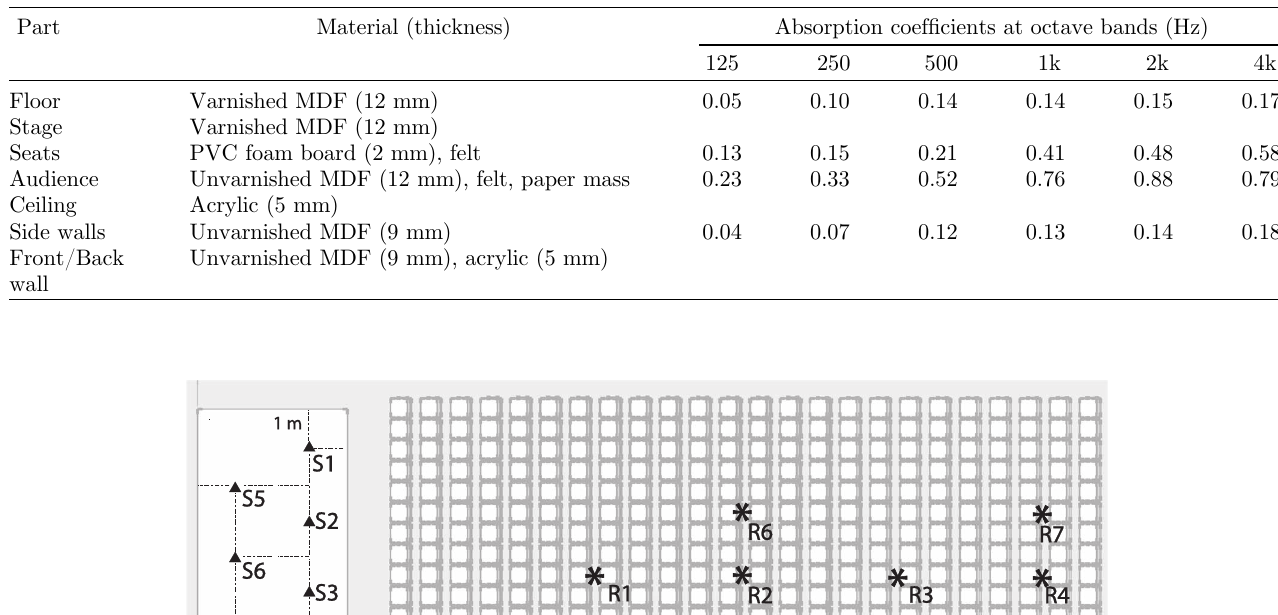
Table 2. The materials and their scaled absorption coef fi cients used in the scale